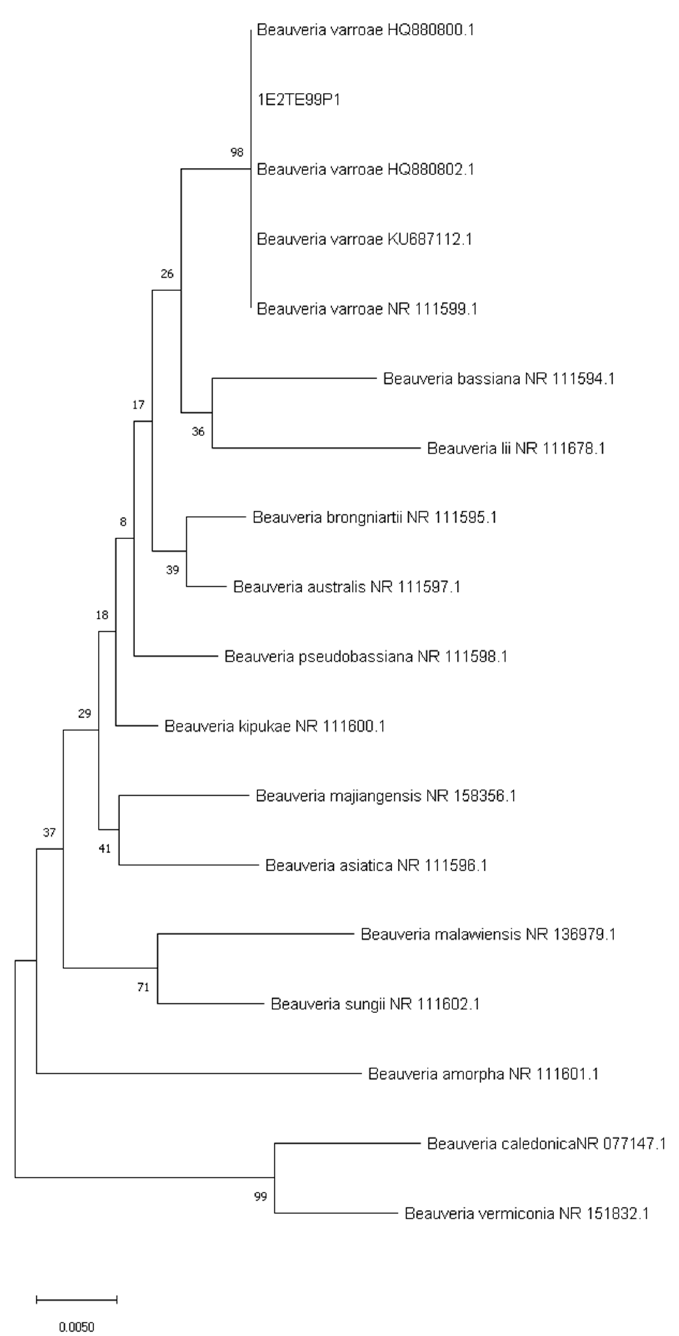
Figure 3. Phylogenetic tree of B. varroae with the new isolate from Greece (1E2T99P1 GenBank accession MZ047310) and related species from GenBank. The species names are followed by the GenBank accession numbers.